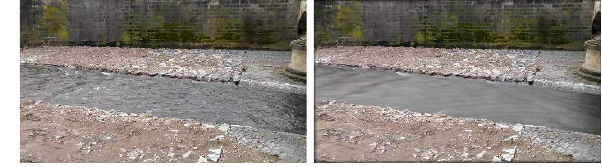
Figure 4: First frame of image sequence (left), Average image after sequential image co-registration (right)